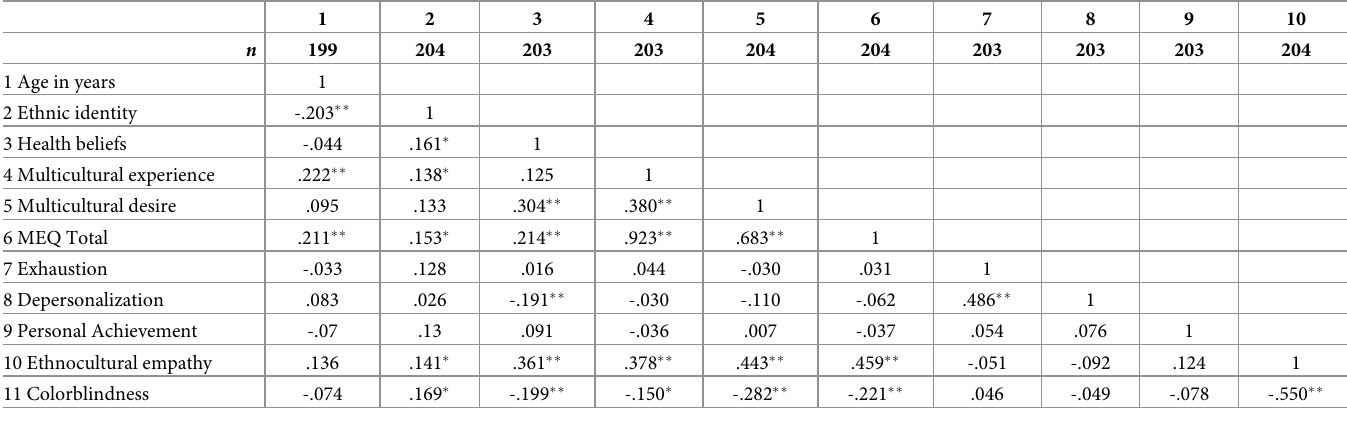
Table 3. Correlations between cultural competence